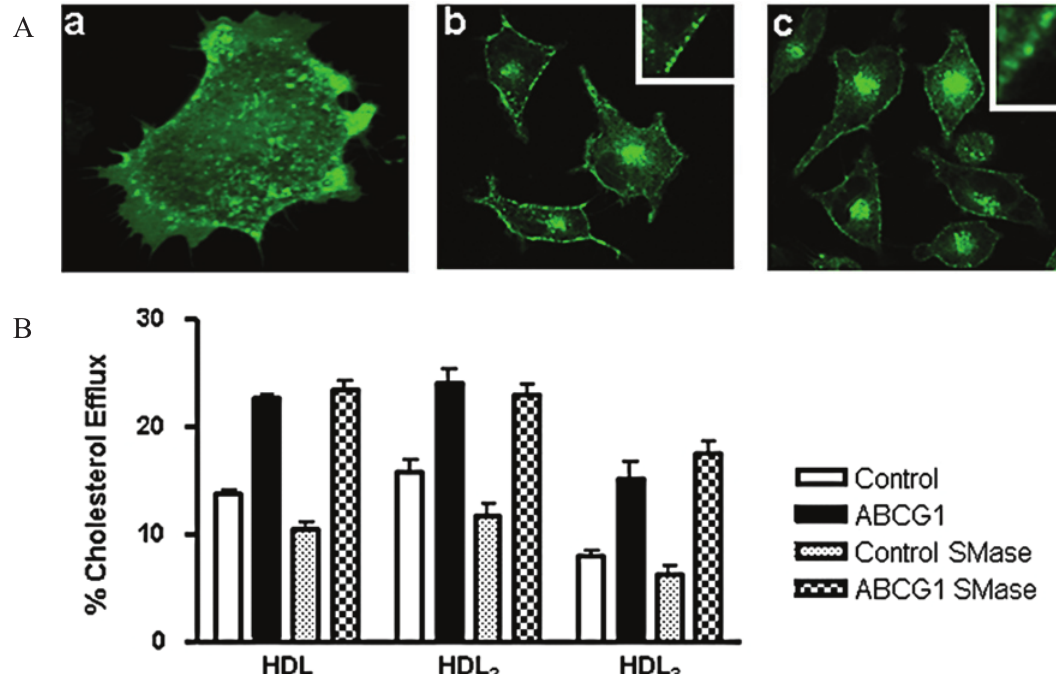
Figure 10. Sphingomyelin hydrolysis increases cycling of ABCG1 between the cell surface and endosomes and ABCG1-mediated cholesterol efflux to HDL. ( A ) Endovesiculation of cell surface ABCG1-GFP. Confocal micrographs of ABCG1-GFP cells treated with sphingomyelinase (SMase) for 10 min ( a , b ) or 30 min ( c ). Insets in ( b ) and ( c ) show numerous subsurface endovesicles containing ABCG1-GFP. Single frame from Movie 5 ( a ) reveals massive endovesiculation of cell surface ABCG1-GFP; ( B ) Control and ABCG1-GFP stably expressing HeLa cells were labeled with 3 H-cholesterol and efflux to 50 μg/mL HDL, HDL 2 , or HDL 3 in the absence or presence of 0.1 U/mL SMase was assessed as described in “Experimental Section”. Note that SMase decreases cholesterol efflux in control cells but does not alter net cellular cholesterol efflux in ABCG1-GFP cells. One-way ANOVA analyses using multiple comparisons revealed that SMase significantly reduced efflux from control cells to HDL, HDL 2 , and HDL 3 ( p < 0.0001, p < 0.0001, and p < 0.05, respectively), and that cholesterol efflux to HDL, HDL 2 , and HDL 3 from SMase-treated ABCG1 cells was significantly increased compared to SMase-treated control cells ( p < 0.0001, in all cases). SMase treatment did not significantly increase cholesterol efflux to HDL or HDL 2 ( p < 0.06 and p < 0.4), but did increase efflux to HDL 3 ( p < 0.003). All values represent mean ± S.D. Data shown is representative of at least three replicate